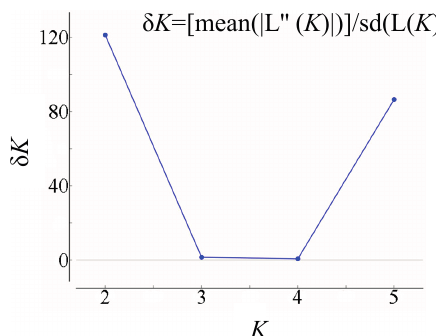
Figure 5. The results of the Bayesian assignment analysis using the Structure